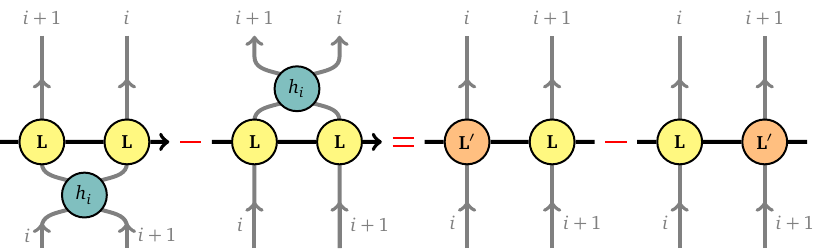
Figure 2: The differential Yang–Baxter equation (see Eq. (14)) takes the form of an operator- valued divergence condition on a one-dimensional lattice. The left-hand side is a schematic representation of the local action of the unitary propagator ∂ telescopic sum of terms with a single ‘defect operator’ which coincides with the derivative of the L -operator (shown in